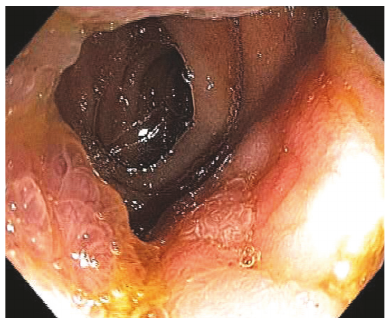
Figure 35: Endoscopic image of a large sessile ileocecal valve adenoma extending into the terminal ileum.